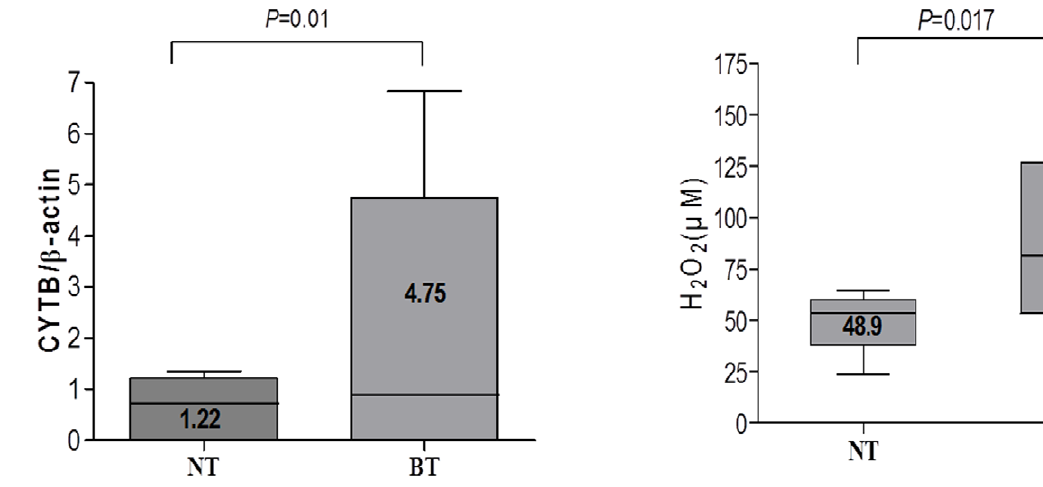
Figure 3. Significant increase in mtDNA copy number in Barrett’s metaplasia tissue. Quantitation of mtDNA copy number was calculated from the ratio of copy number (copies/ m l) from mtDNA cytochrome b and nuclear ß-actin gene using real-time PCR. The average mtDNA copy number was significantly increased in Barrett’s metaplasia tissues (BT) compared to those from adjacent normal mucosal tissues (NT) ( P =0.01).